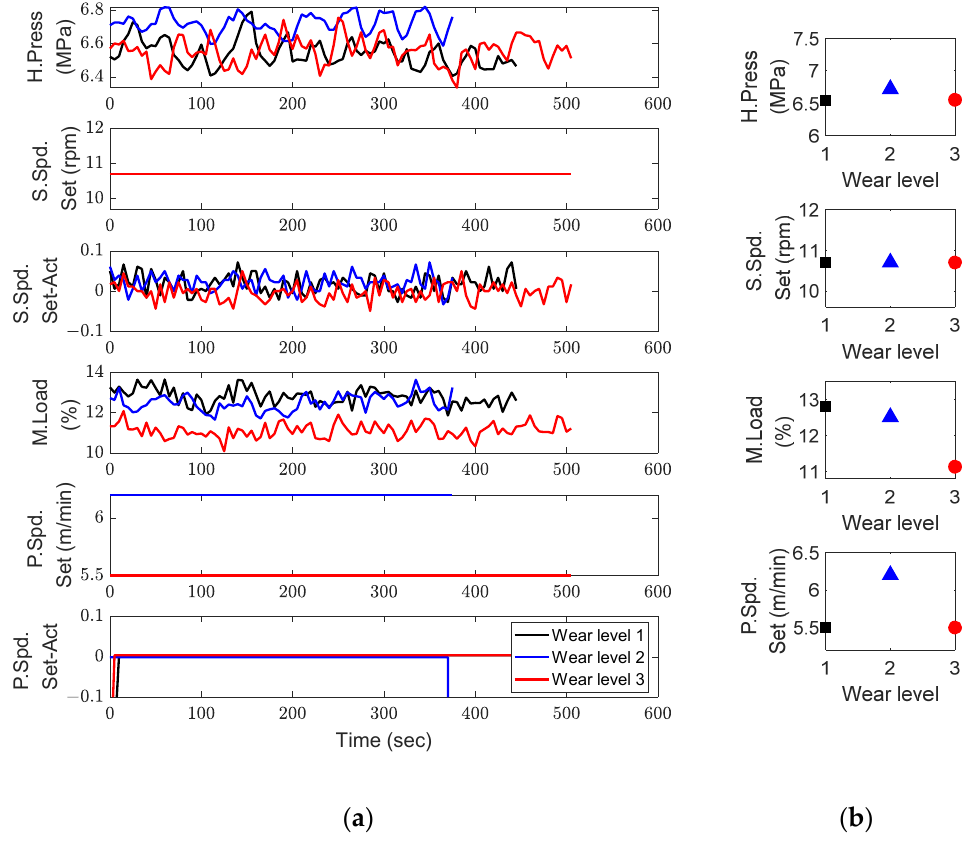
Figure 8. Experimental data according to the level of screw wear, keeping catheter production and materials the same: ( a ) operational data; ( b ) mean of the operational data.